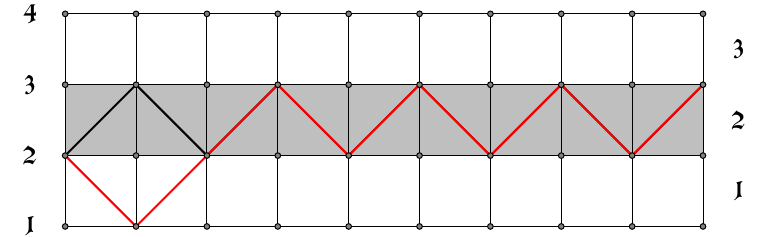
Figure 14 . The minimal path (black) and a path with weight 1 (red) in the next-to-vacuum module of the Lee-Yang restricted solid-on-solid model L 2 ; 5 , labeled by a = 2, b = 2, and c = 3. primary Virasoro (cid:12)eld has conformal dimension (cid:1) = (cid:0) 1 . The minimal path (with weight 5 zero) that corresponds to the highest weight state is shown as the black line in (cid:12)gure